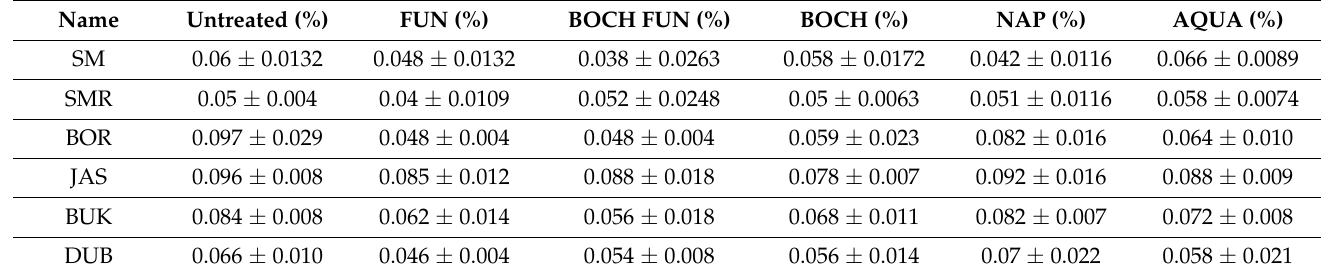
Table 4. Mass change of selected treated wood samples after 30 s of flame